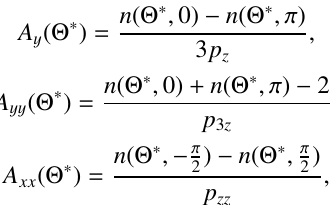
CH 2 film has been used as a proton target and in order to evaluate the background originating from the CH 2 Carbon wire measurement was